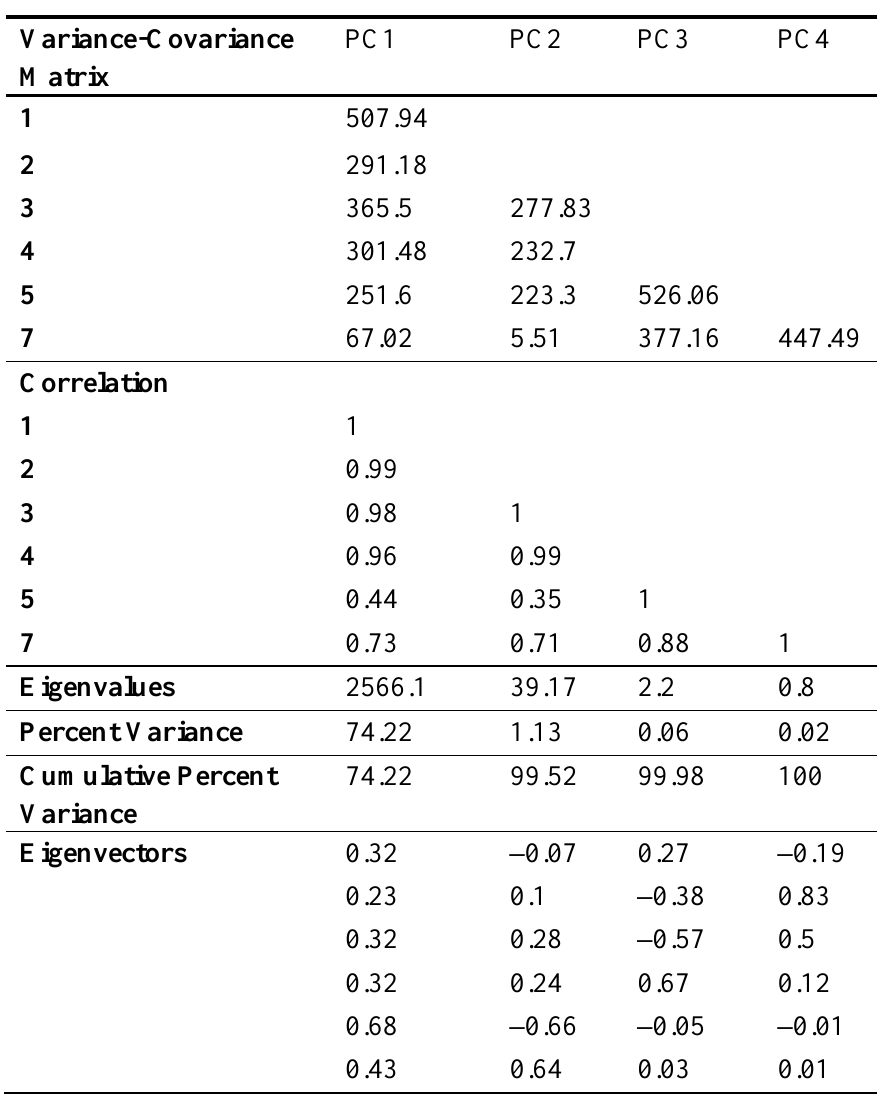
Table 1. Results of principal component analysis of west Qatar